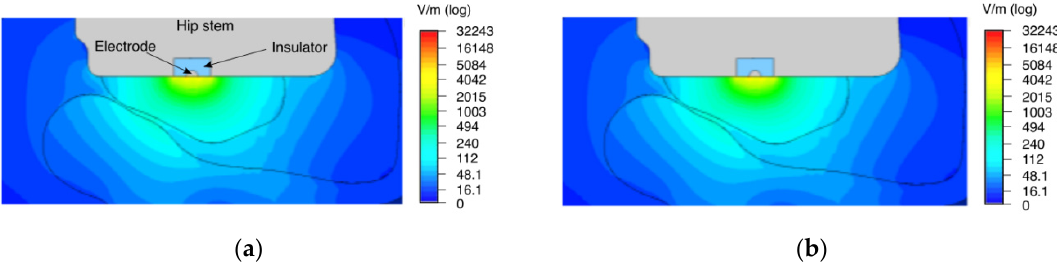
Figure 3. Distribution of the electric field strength in the transversal plane of the porcine femur. Conductivity values of ( a ) yellow bone marrow (case study 1) [22] and ( b ) red bone marrow (case study 3) [23] have been employed here.